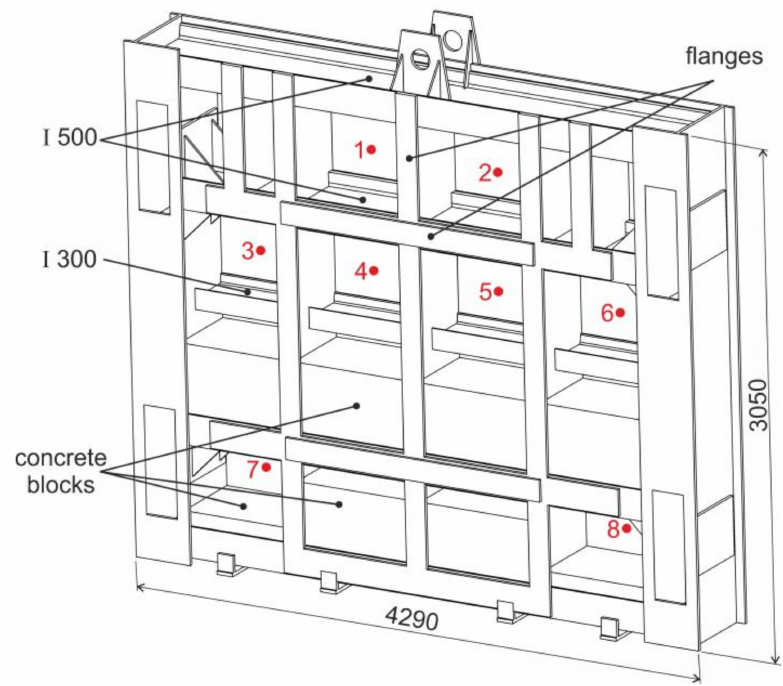
Figure 17. Deformed lower part of the bronze